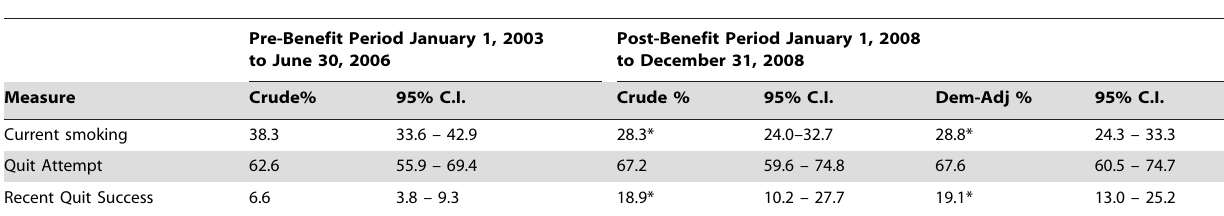
Table 1. Comparison of Pre-, Post-Benefit Periods on Smoking Prevalence And Quitting Behavior.